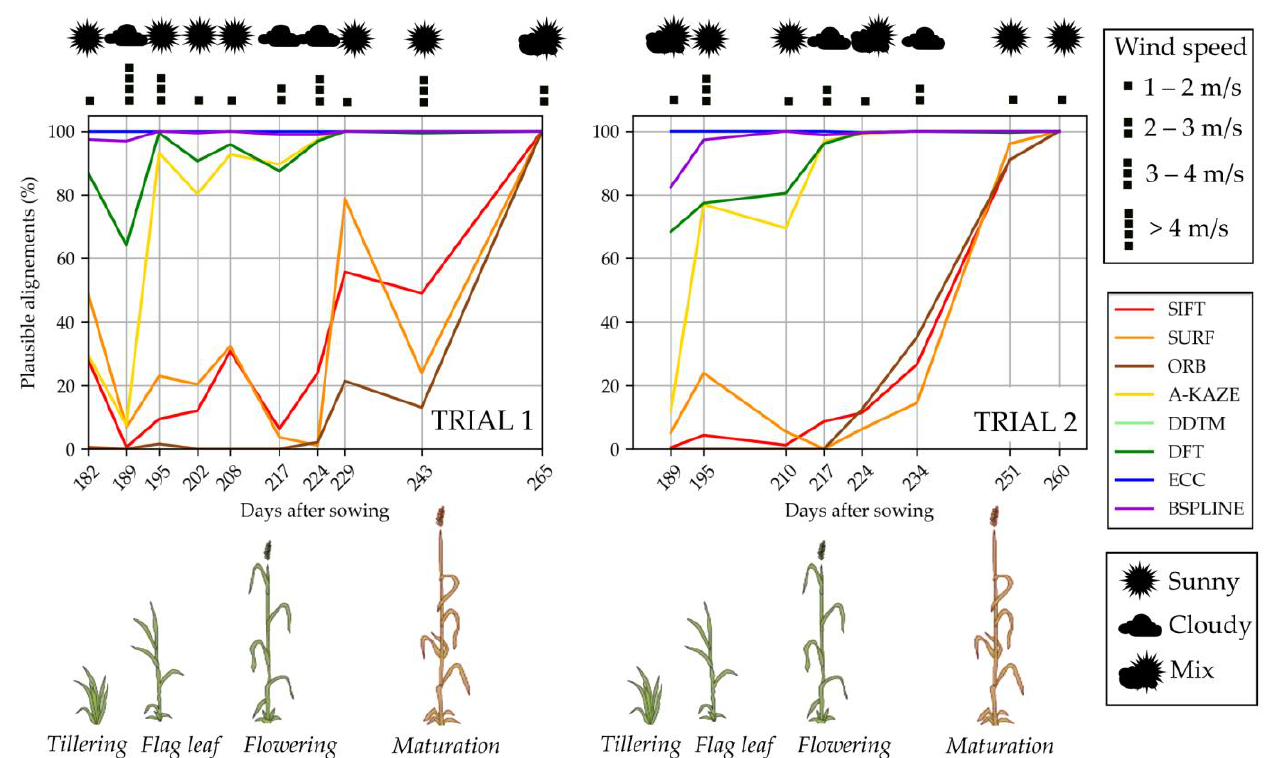
Figure 8. Evolution of the percentage of plausible alignments for the 490 nm images. Scores are presented for the two trials along with environmental information (wind speed and cloudiness).